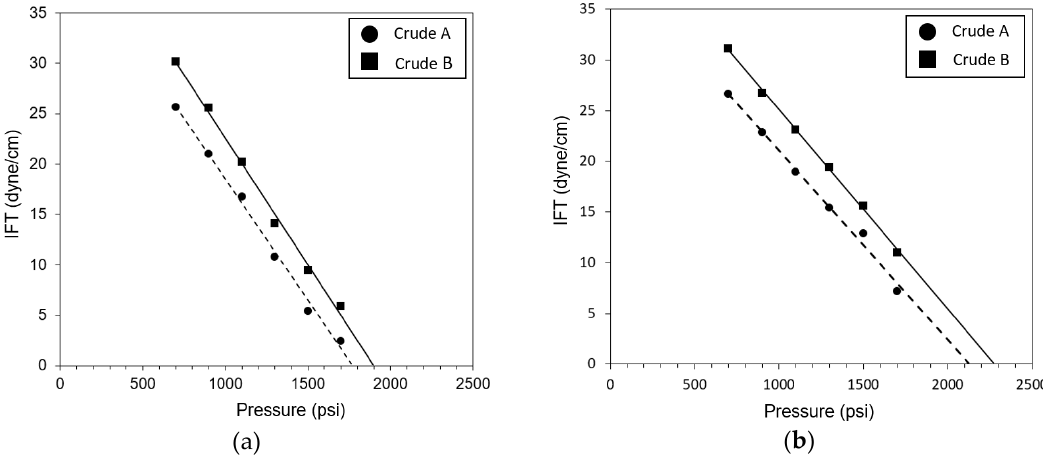
Figure 6. IFT versus CO 2 injection pressure for samples A and B at ( a ) 60 and ( b ) 80 ◦ C without additives, i.e., pure CO 2 and crude oils.